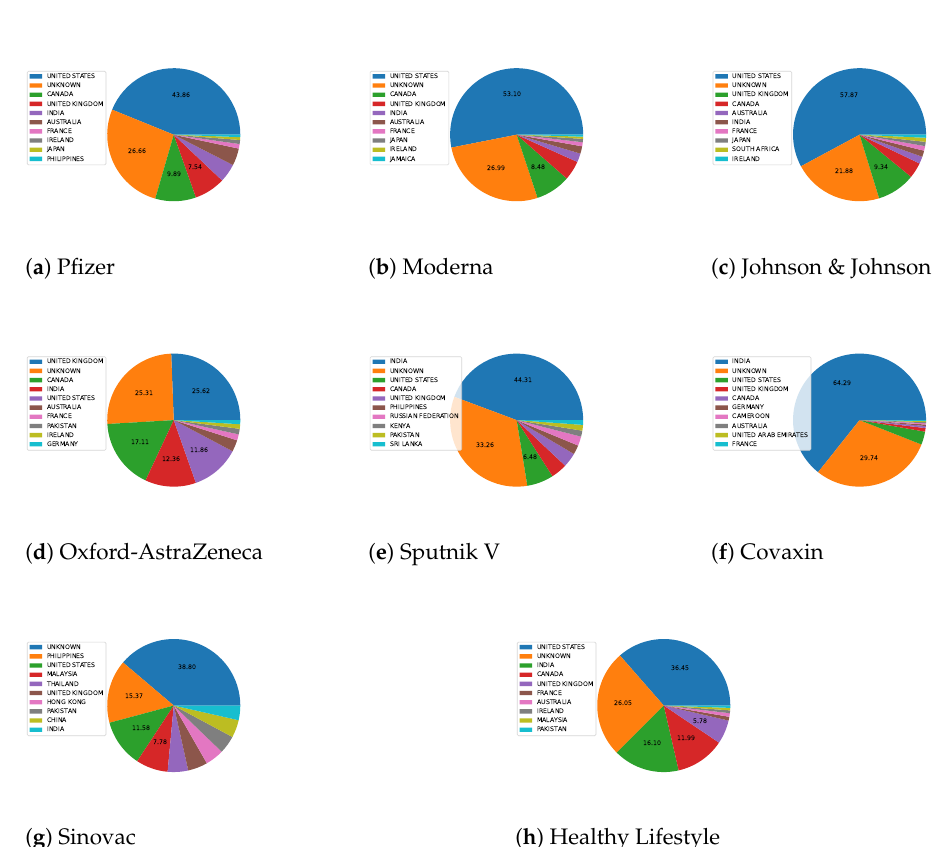
Figure 4. Top countries with tweets for Twitter Dataset 1 (different vaccines) and Twitter Dataset 2 (healthy lifestyle).